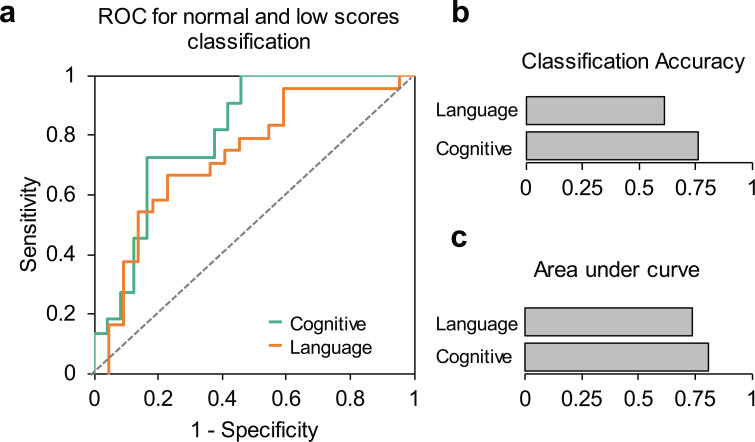
Evaluation of the prediction models.(a) The receiver-operating-characteristic (ROC) plots show specificity and sensitivity with cortical microstructural measures used as features to classify normal (>85) versus low (≤85) cognitive or language scores. (b and c) show accuracy and area under ROC curve for language and cognitive classification model.